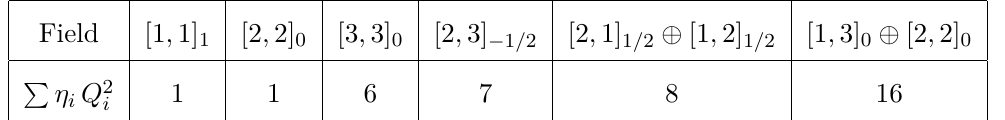
for some possible BSM Loryons with f i